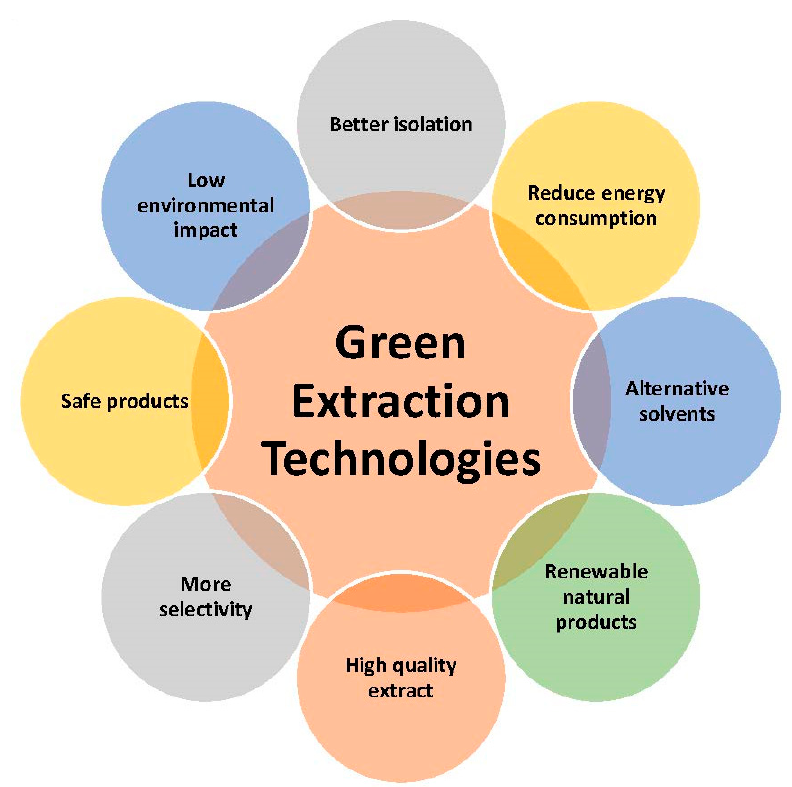
Figure 2. Advantages of the use of green technologies to extract bioactive compounds from plant sources.